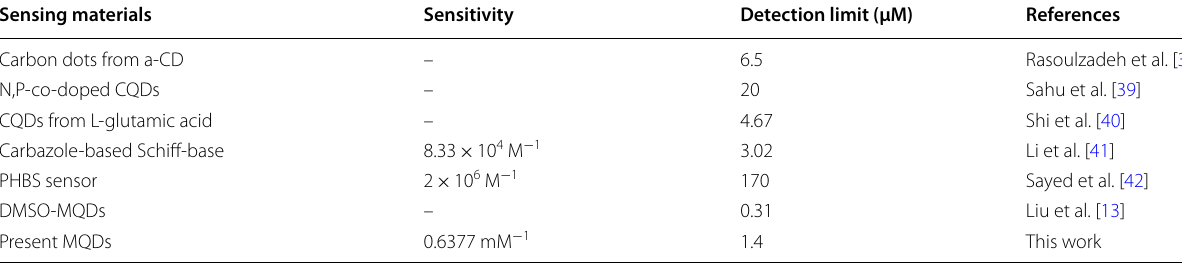
Table 1 Comparison of sensing performance between present MQDs and previous materials Sensing